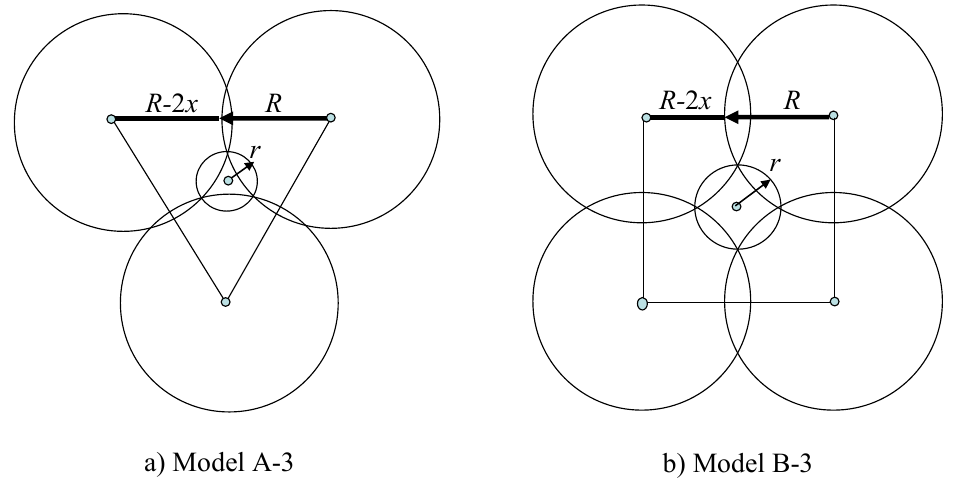
Figure 3. Optimal coverage with two sensing